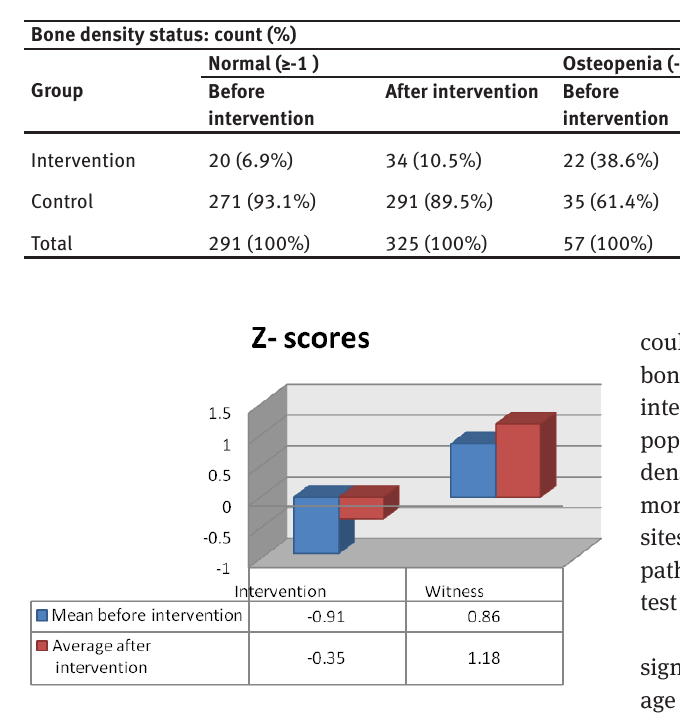
Figure 2: Line chart of Z-score changes of bone density in patients referred to The Bone Density Clinic of Semnan’s Kowsar Hospital in 2018, by intervention and control groups.